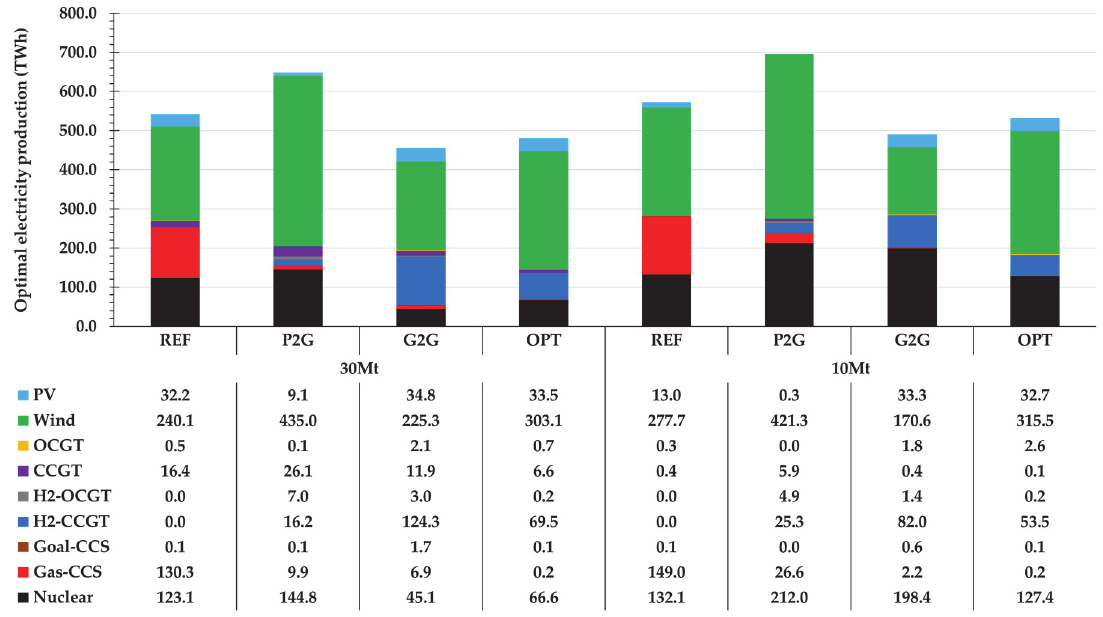
Figure 5. Optimal electricity production in different scenarios.